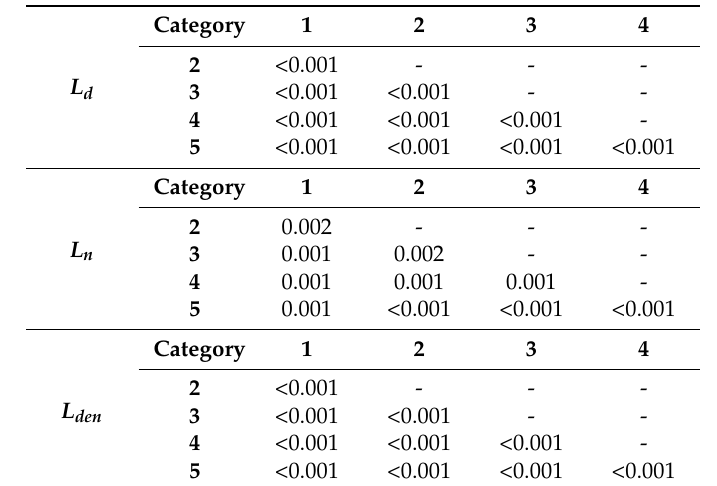
Table 3. p -Values with Holm adjustment of pairwise comparisons of road categories using Mann-Whitney U test.